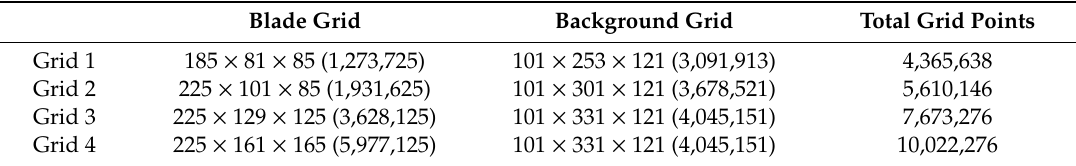
Table 1. Four sets of grids used in the Reynolds-averaged Navier–Stokes (RANS) simulation. Blade Grid Blade